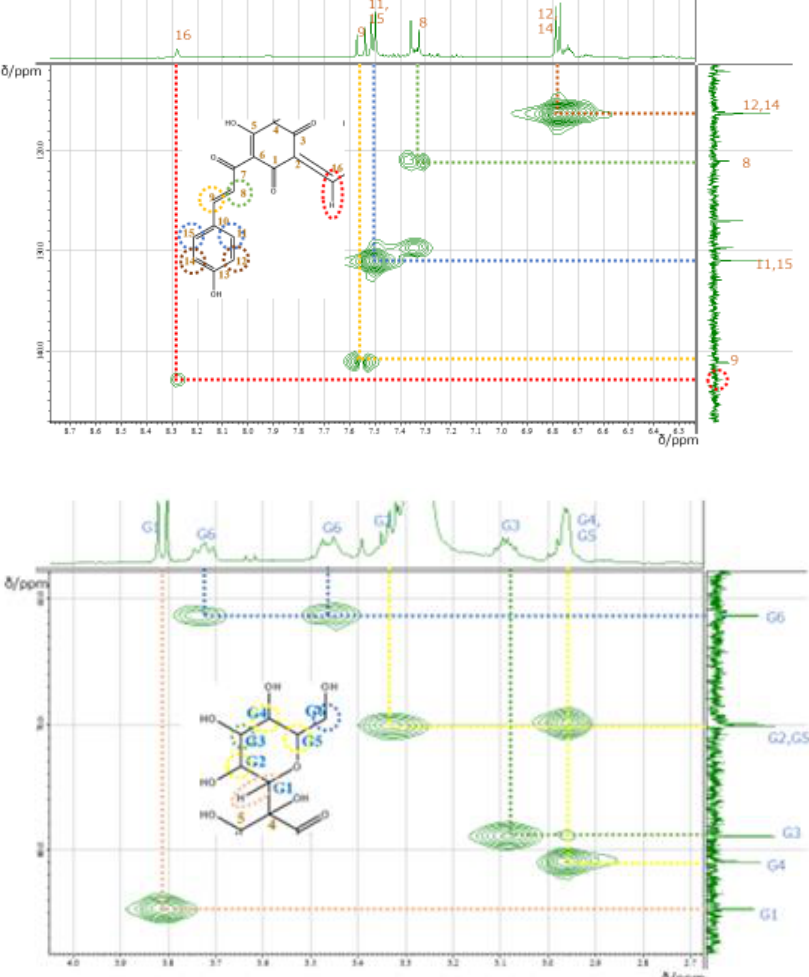
Figure 7. HMQC spectra of carthamin 3′ potassium salt recorded in DMSO- d 6 at 30 °C under low ( top ) and high ( bottom ) magnetic fields.